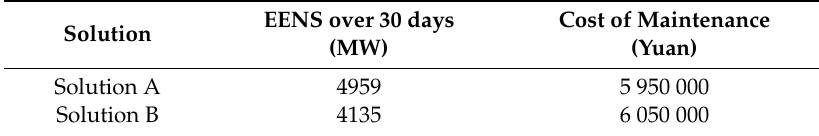
Figure 5. Comparison of system reliability during maintenance period. EENS: expected energy not supplied. Table 3. Information of transformers to be